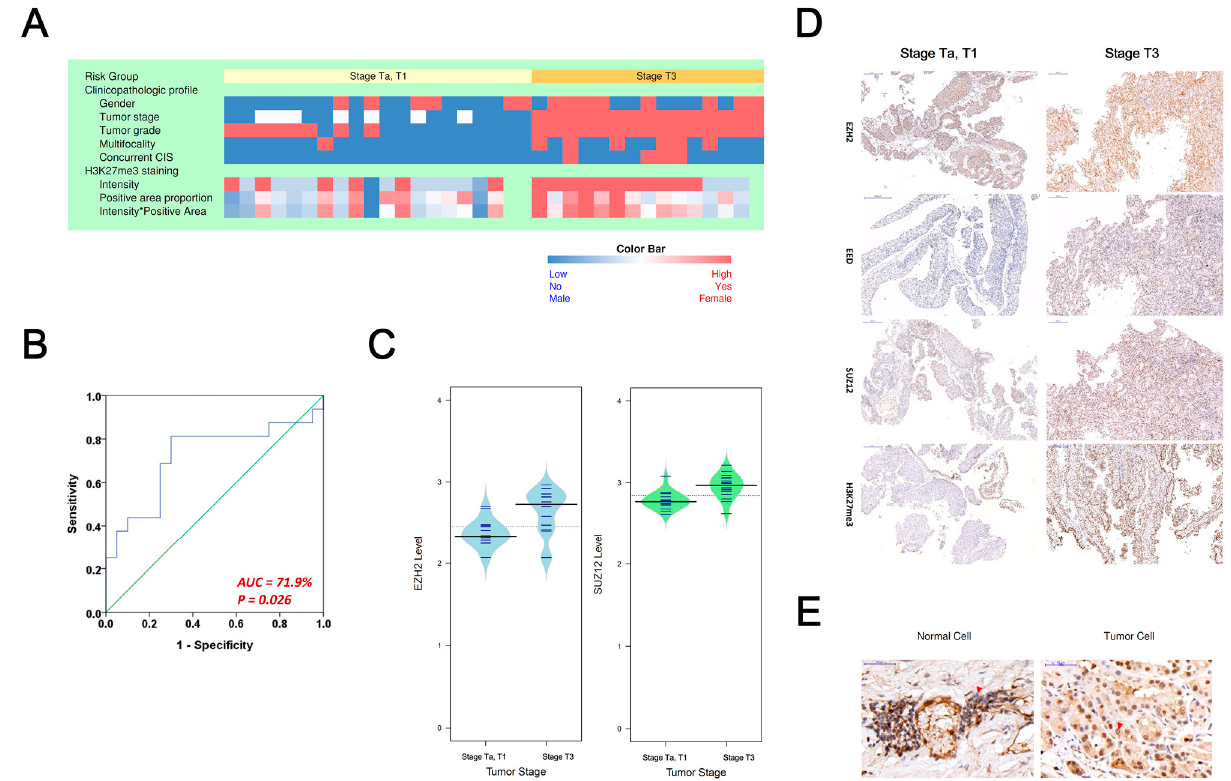
Figure 2. An evaluation of PRC2 oncogenic signature in upper-tract urothelial carcinoma. ( A ) The heatmap of clinicopathologic variables of UTUC patients and H3K27me3 staining intensities. ( B ) The performance of the risk model in Equation (1) for classifying advanced stage (n = 16) and low stage (n = 20) UTUC tissue samples, based on the risk score values calculated by the model with quantified RNA expression levels. ( C ) Distributions of EZH2 and SUZ12 levels in tissues with stage Ta/T1 or T3. ( D ) Representative immunohistochemical staining images of EZH2, EED, SUZ12, and H3K27me3 expressions in low stage and advanced stage UTUC. Magnification is × 100. ( E ) EZH2 protein expressions in normal urothelium tissue and UTUC at the 1:1 scale.